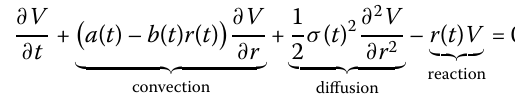
calculated. To be consistent with Category 2 instruments, the measure used after the valu- ation date is the risk-free measure and it is the physical measure before. Flowchart 1 shows the calculation steps for Category 3 instruments. For more details, see the joint committee in the PRIIPs KID